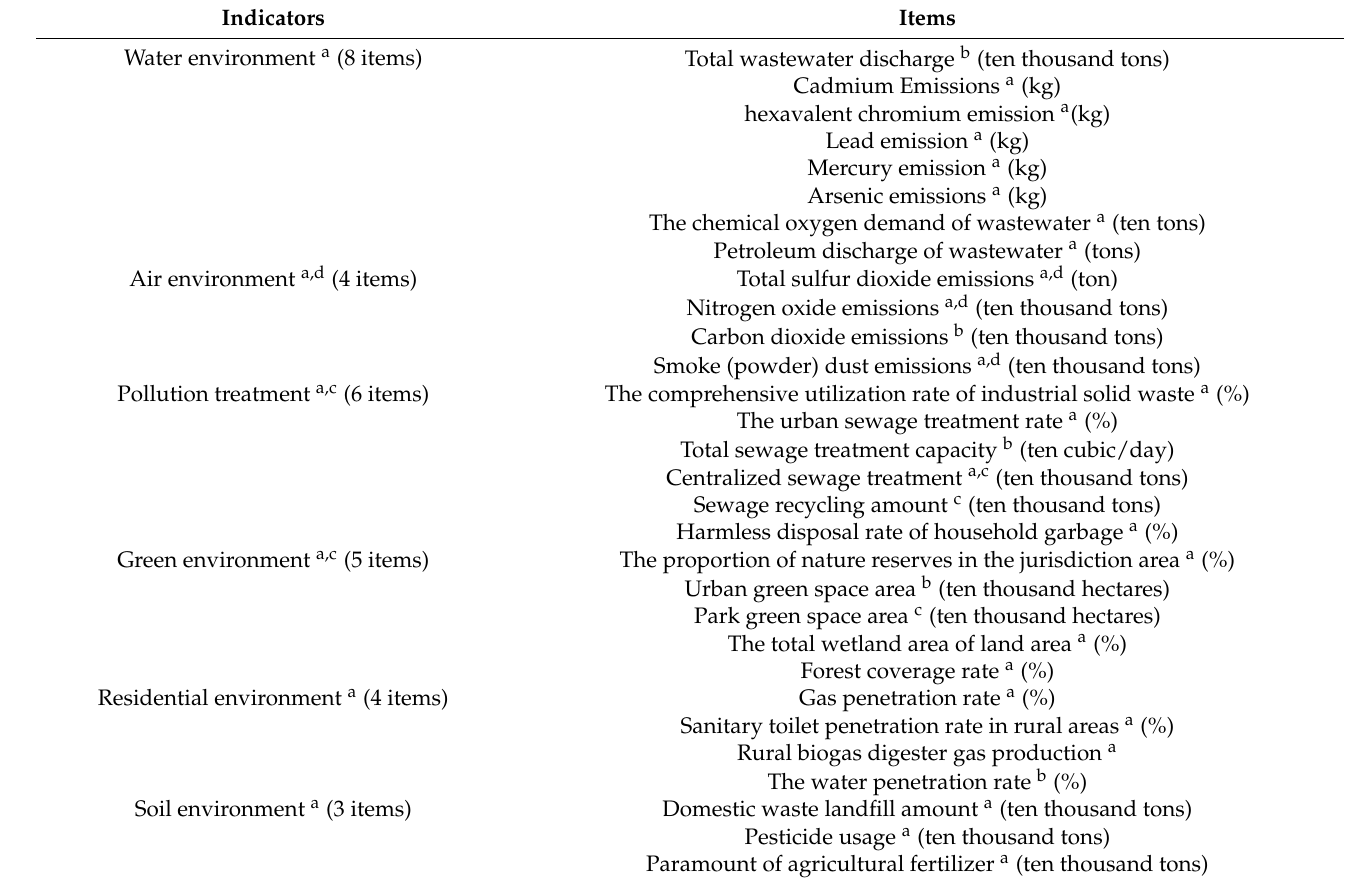
Table 1. Indicators and items to measure ecological